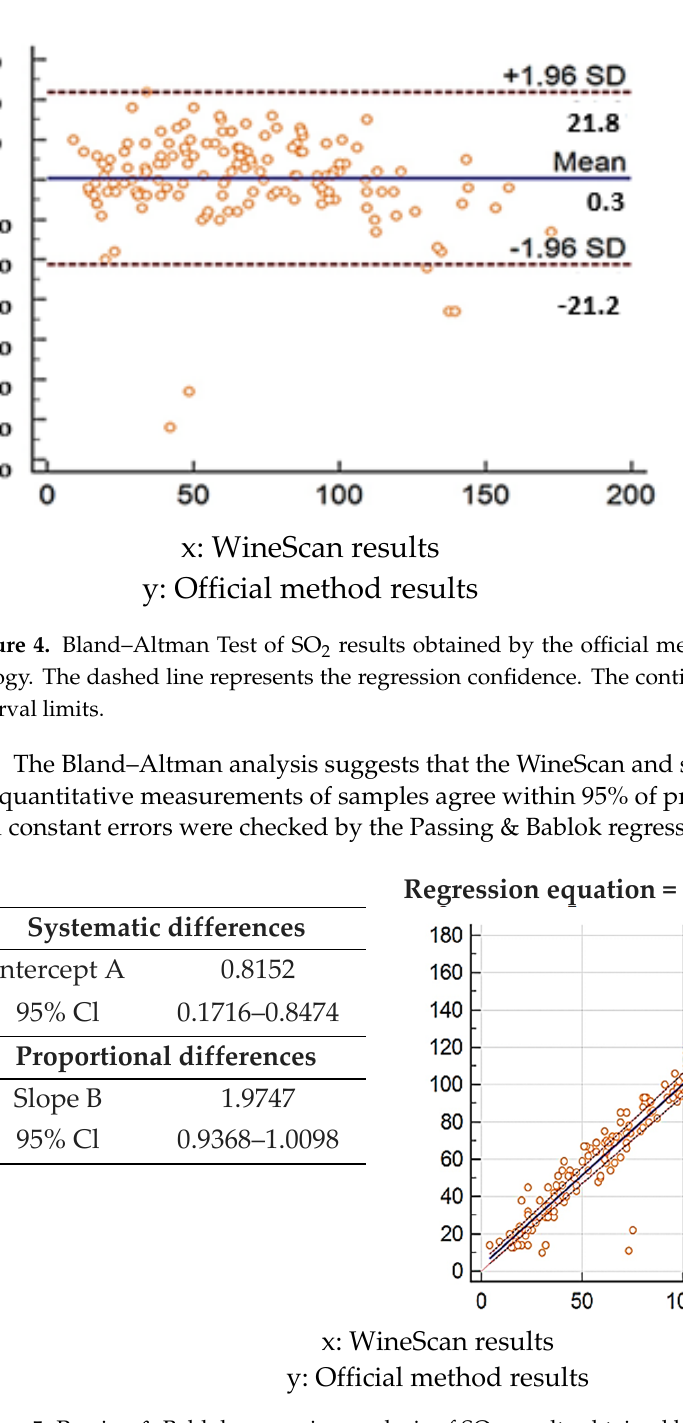
Figure 5. Passing & Bablok regression analysis of SO 2 results obtained by the official method and WineScan technology. The line y = x is represented by the dashed line. The regression line corresponds to the solid line.